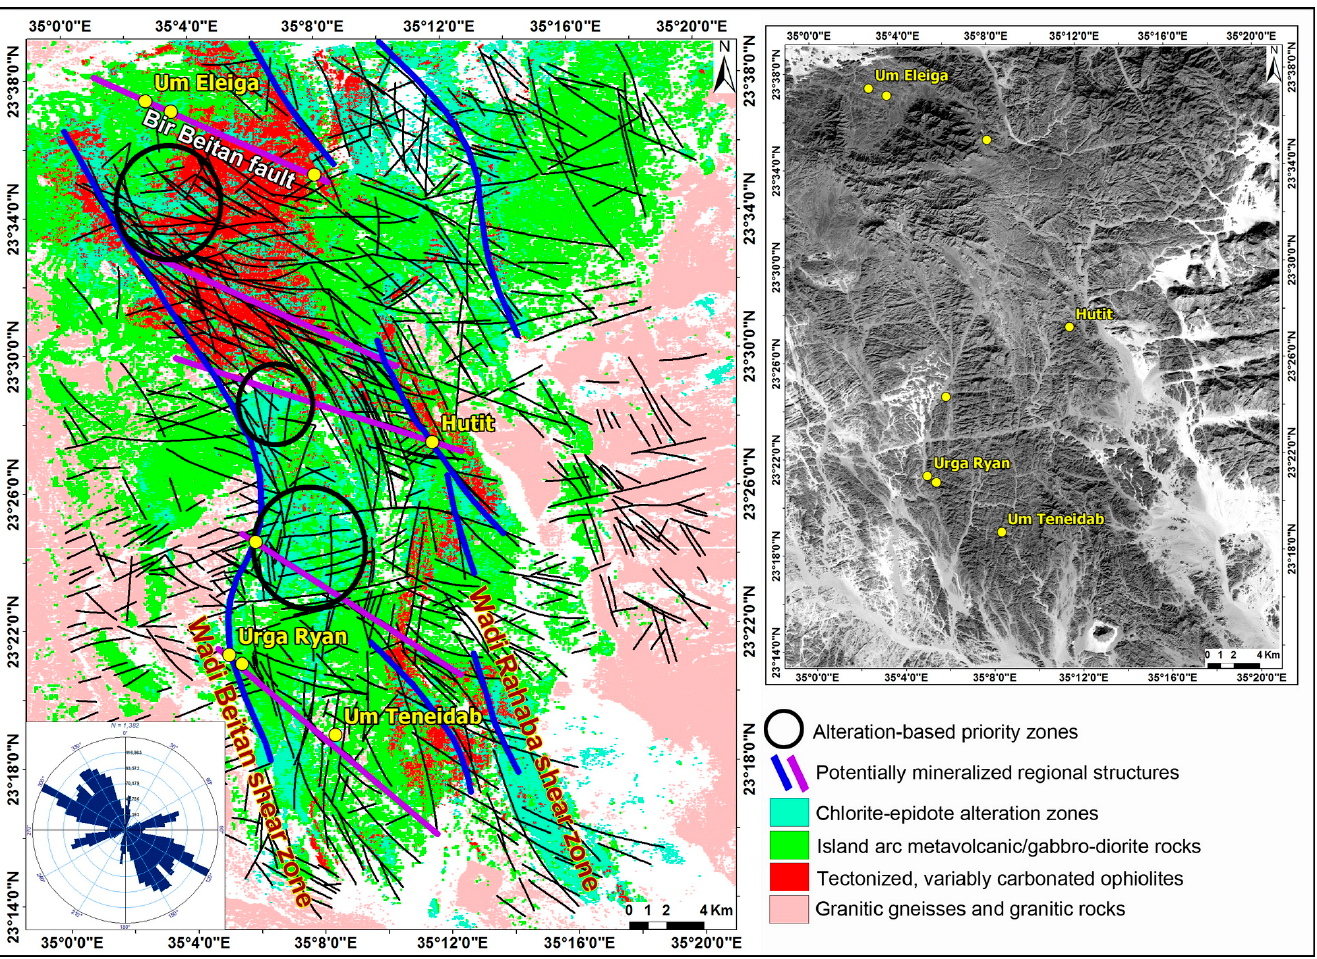
Figure 17. A fused lithological–structural map generated by merging the extracted structural lineaments and mineralogical index vector images of the study area. The inset is a rose diagram of the main structural lineaments. To the right is a grayscale ASTER-band 1 image of the study area. Zones with potential for hidden resources, considered as priority exploration targets, are highlighted.